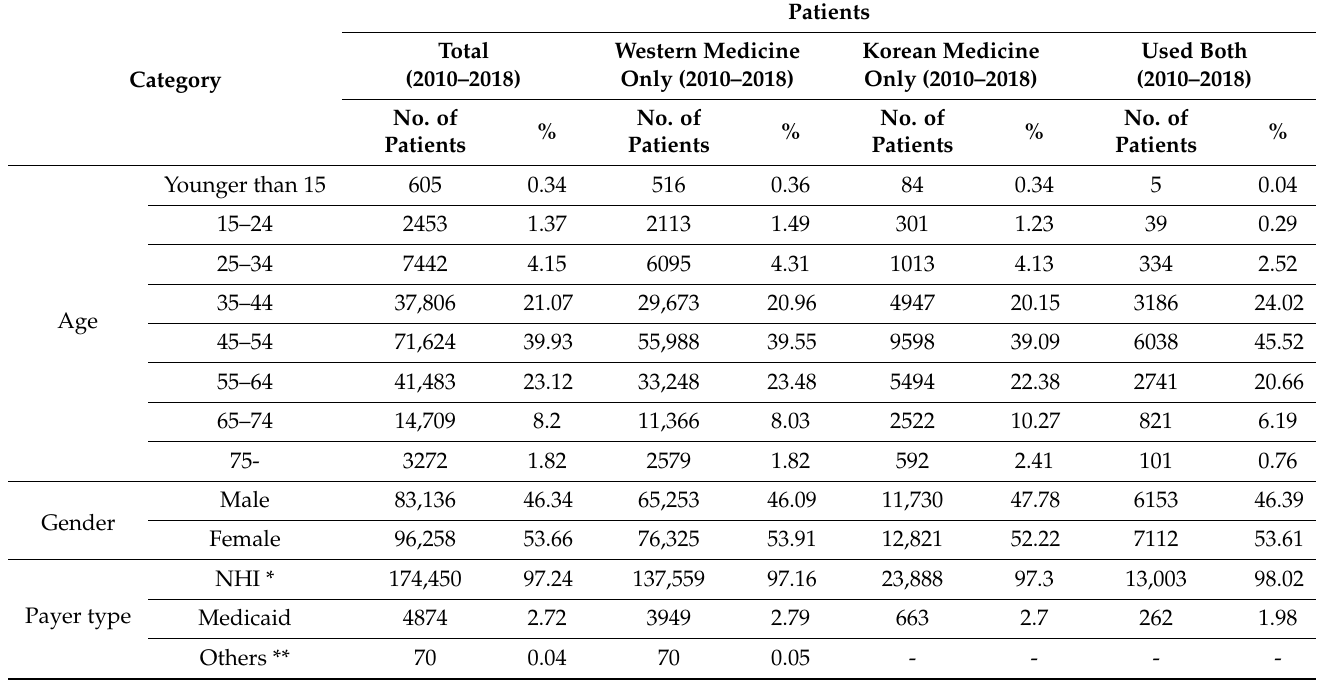
Table 2. Basic characteristics of